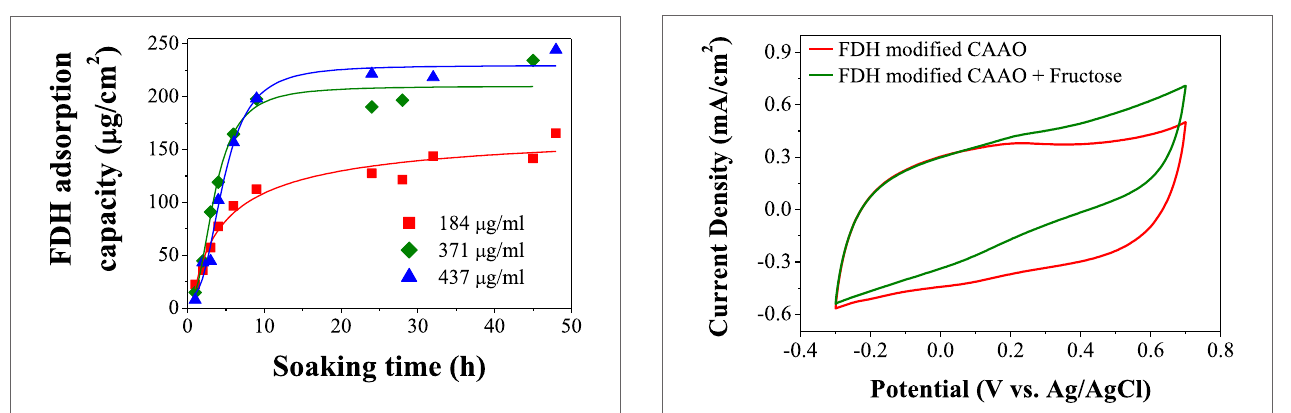
FigUre 6 | cyclic voltammograms of caaO films loaded with FDh before and after the addition of d -fructose